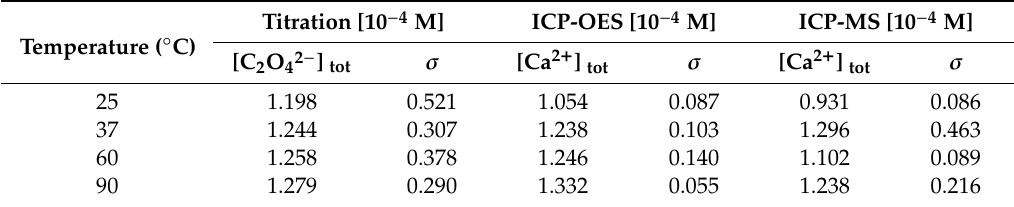
Table 4. The results of solubility of COM measurements in ultrapure water as a function of the temperature. The reported results are shown as the mean total ion concentration along with the standard deviations, σ